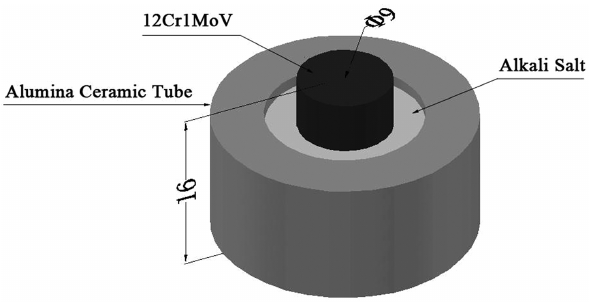
Figure 1: The schematic of the creep testing